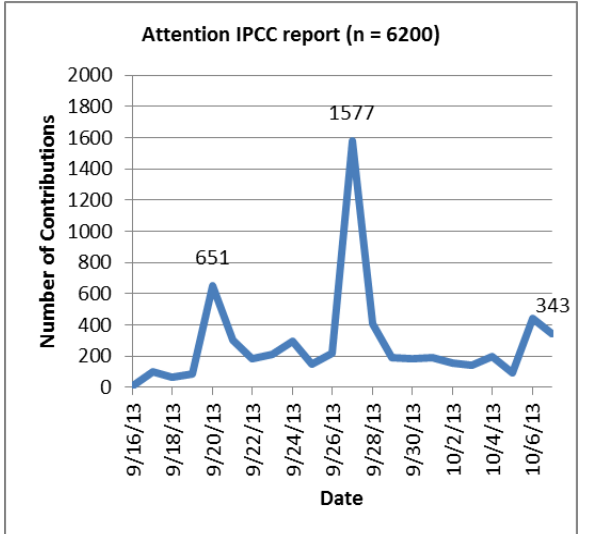
Figure 2. Dynamics of attention during COP19.